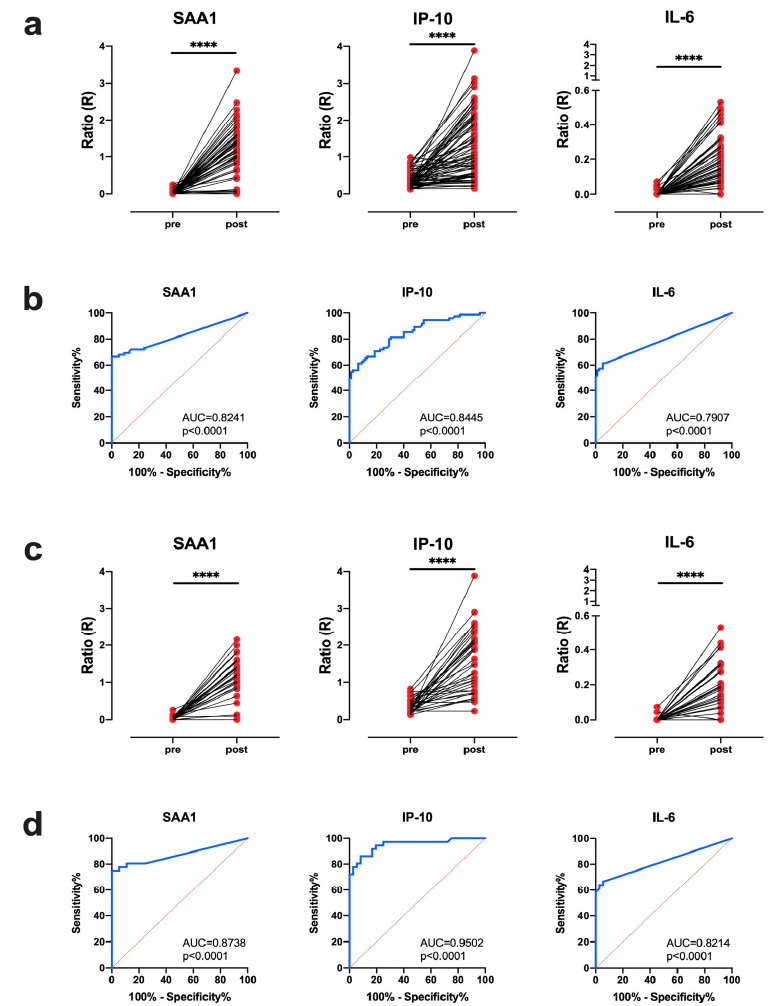
Figure 1. Distinctive increase in serum SAA1, IP-10 and IL-6 after MTB infection. SAA1, IP-10 and IL-6 levels were measured by UCP-LFA in serum from MTB Erdman (500 CFU, n = 53; 15 CFU, n = 12; 1-7 CFU, n = 10) infected rhesus macaques with or without BCG pre-vaccination ( n = 75, Tables S1–S5). Endpoints varied between 6 weeks and 52 weeks after infection. Results are displayed as the Ratio value (R) between Test (T) and Flow-Control (FC) signal based on relative fluorescence units (RFUs; excitation at 980 nm and emission at 550 nm) measured at the respective lines. ( a , b ) Analysis of three biomarker levels pre and postinfection in MTB Erdman infected rhesus macaques ( n = 75). ( c , d ) Analysis in untreated, infected control animals from high- (500 CFU, n = 24) and low-dose (15 CFU, n = 12) MTB infection studies ( n = 36). ( a , c ) Significant differences between biomarker levels ( y -axis) pre and postinfection were determined by Wilcoxon matched- pairs signed rank tests. ( b , d ) The ability to distinguish pre from postinfection states in the same animals was evaluated by ROC curve analysis, including Area Under the Curve (AUC) measurements (ROC-AUC). AUC: area under the curve; p -values: **** p <